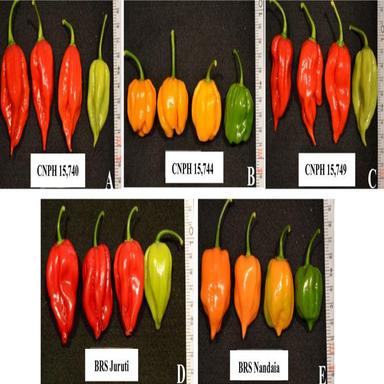
Fruits of advanced endogamic lines: A. CNPH 15,740; B. CNPH 15,744; C. CNPH 15,749; and cultivars: D. BRS Juruti and E. BRS Nandaia.